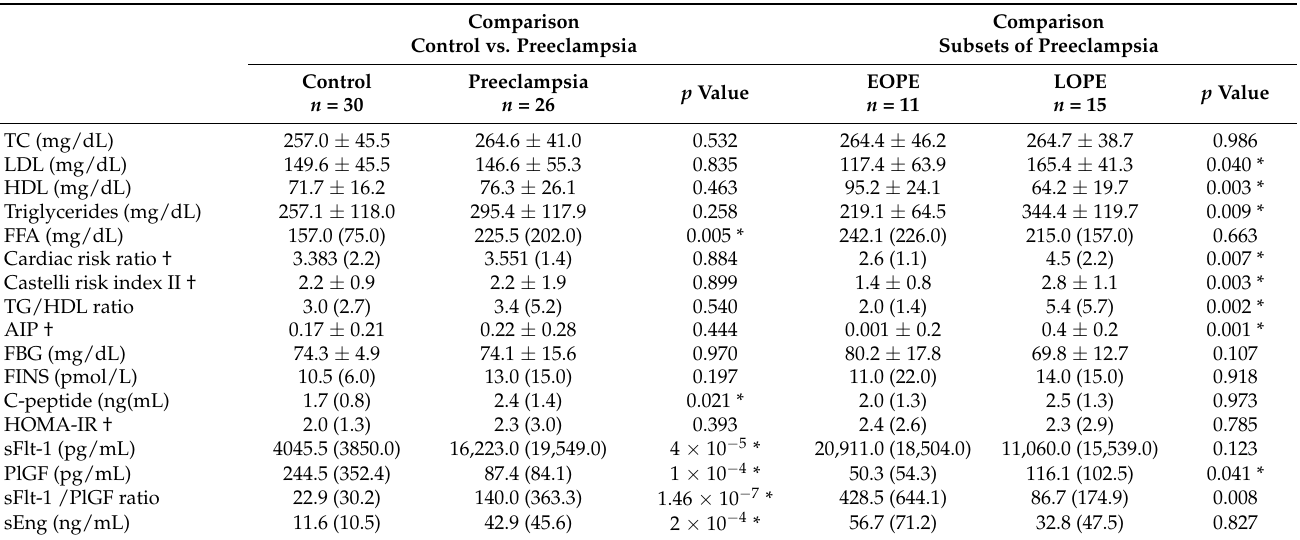
Table 2. Analysis of maternal serum